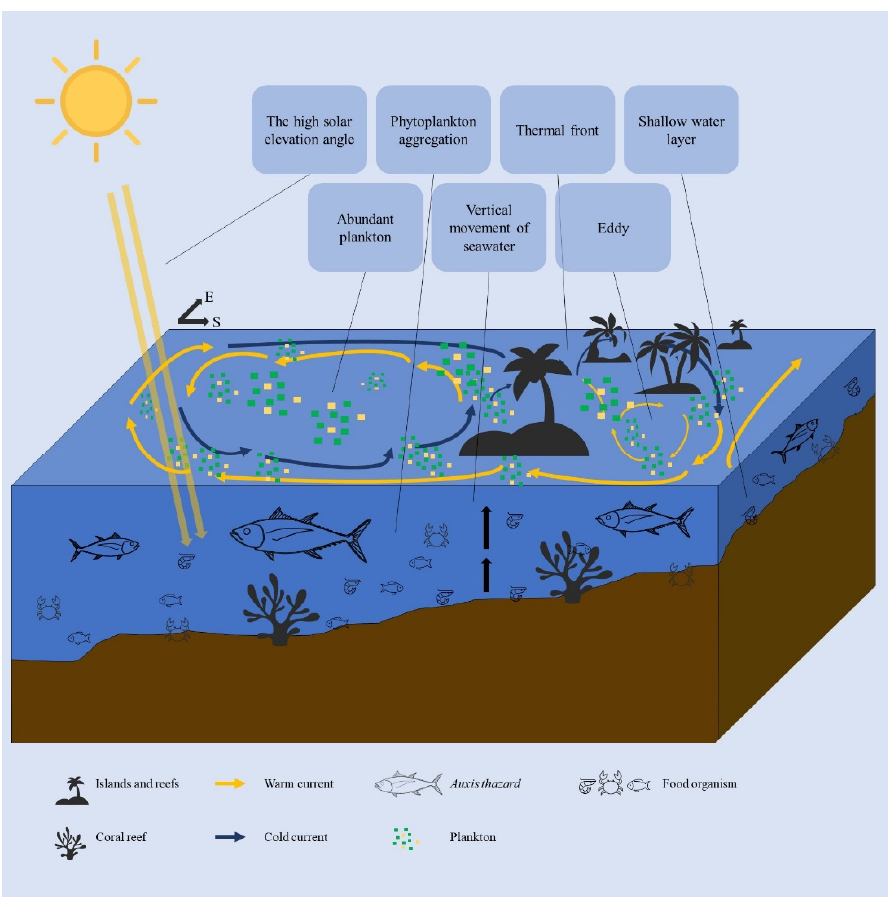
Figure 7. Environment impacts the habitat of A. thazard in summer.